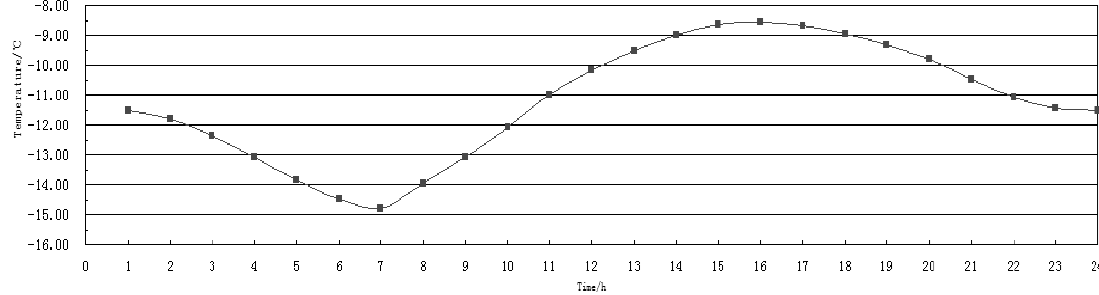
Figure 4. Temperature meteorological model of standard day in January in Beijing.